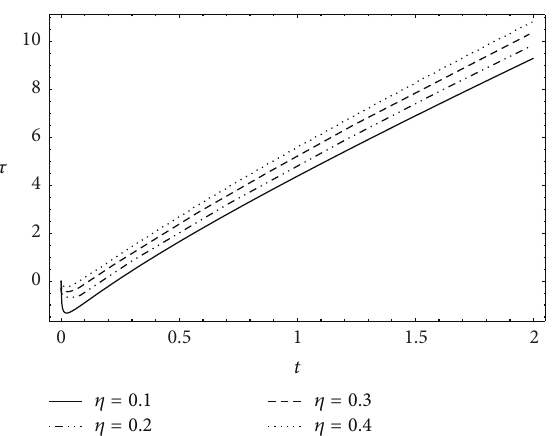
Figure 11: Variations of skin friction 𝜏 along 𝑡 for different values of 𝜂 corresponding to stepped temperature of the plate with Pr = 7.0 .